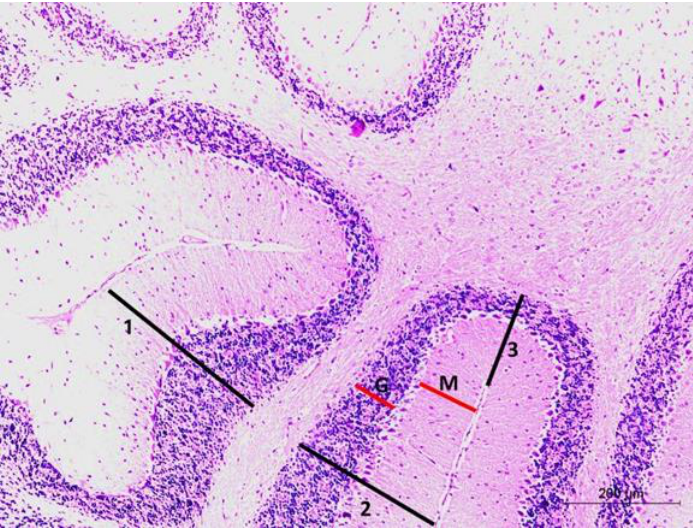
Figure 1. Photomicrograph of hematoxylin and eosin-stained section of the mouse cerebellar cortex at the mid-sagittal section. Measurements of the thickness of the molecular cell (M) and granular cell (G) layers were performed at three different areas: The cortical thickness of the folium surface (1), cortical thickness facing the fissure (2), and cortical thickness at the fissure base (3).